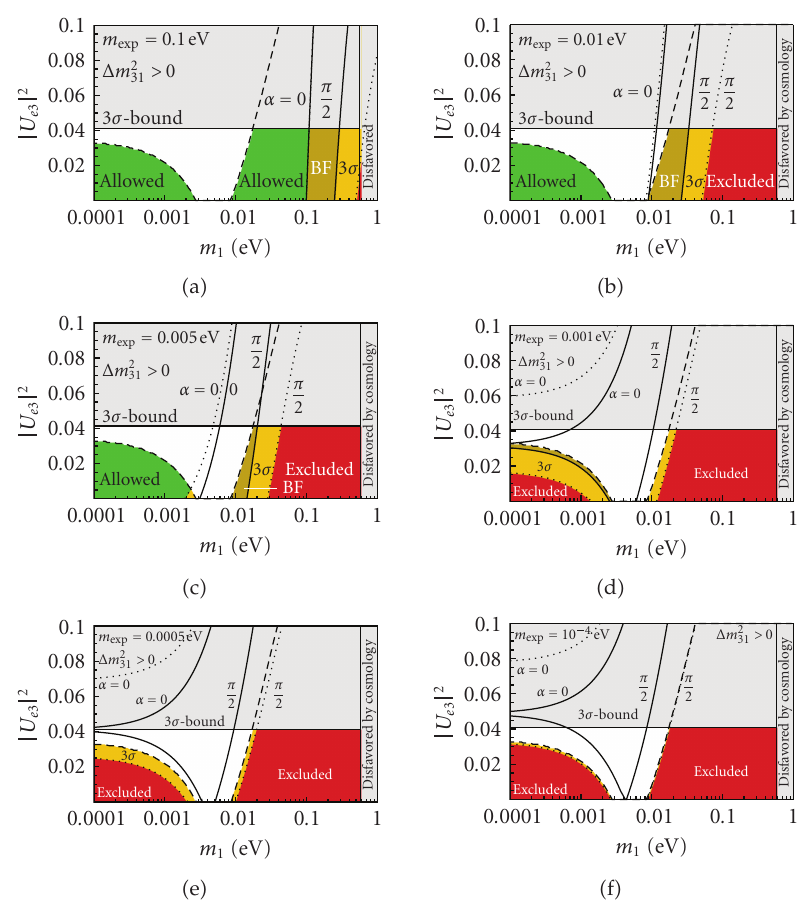
Figure 3: Normal neutrino mass ordering. Areas in the m 1 - | U e 3 | 2 parameter space in which information from neutrinoless double beta decay experiments could be gained. Di ff erent experimental bounds m exp on the e ff ective mass are shown, as well as the current 3 σ limit on | U e 3 | 2 . The range of the lower limit on | U e 3 | 2 is shown within solid lines in dark yellow for the best-fit values (cid:6) “BF” (cid:7) of the oscillation parameters. The light yellow area within the dotted lines is the lower limit for the 3 σ -ranges. The left and right borders of these areas correspond to α (cid:8) 0 and α (cid:8) π/ 2, respectively. The red areas are excluded, the green and white areas are